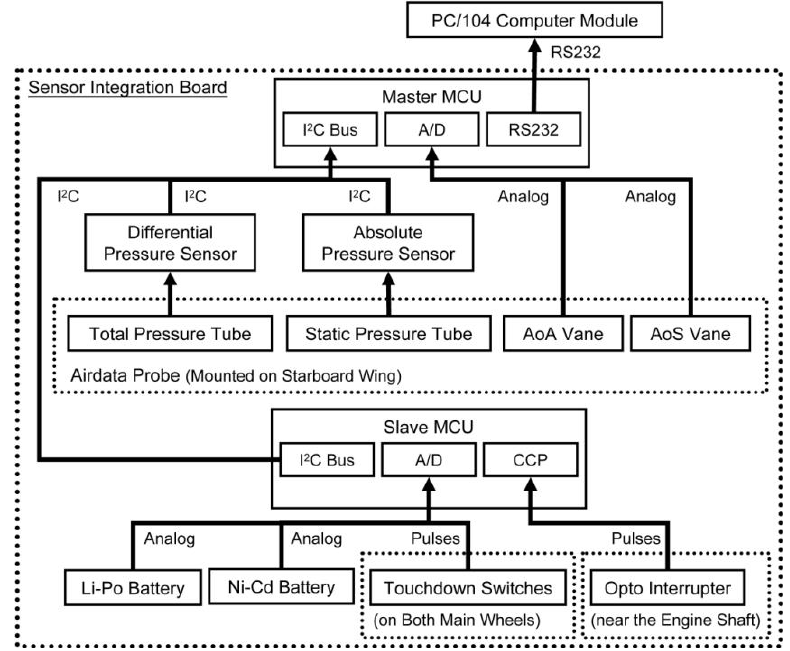
Figure 4. Sensor Integration Board